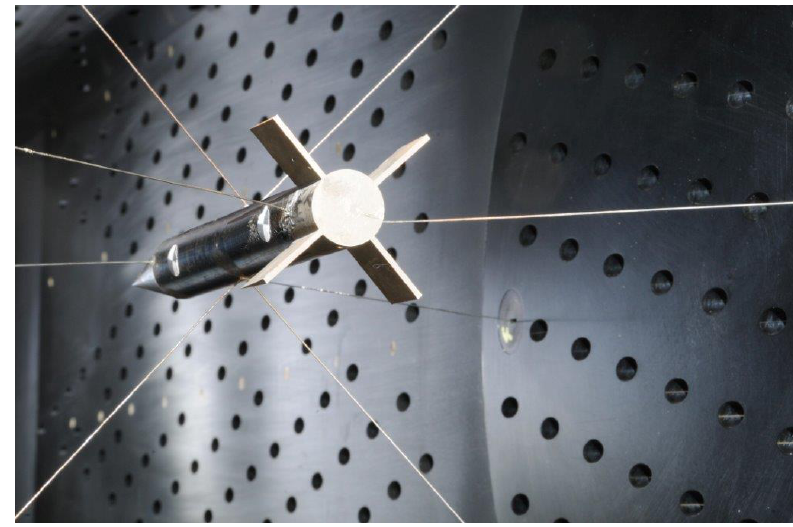
Figure 3. Wire suspension setup in the ISL’s trisonic wind